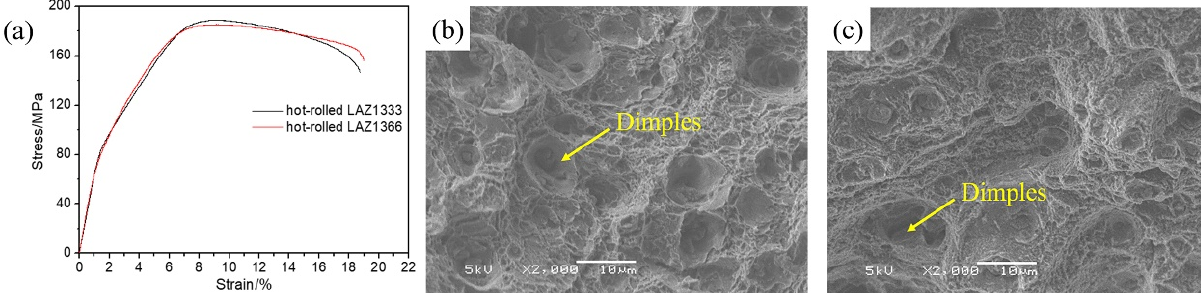
Figure 12. Room temperature tensile stress–strain curves and fracture morphology of the hot-rolled LAZ13 xy ( x = 3, 6 wt%, y = 3, 6 wt%) alloys: ( a ) tensile stress–strain curves, fracture morphology of hot-rolled ( b ) LAZ1333 and ( c ) LAZ1366.